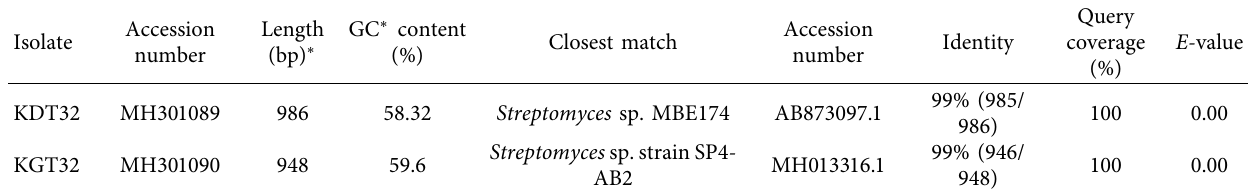
Figure 8: The amplified 16S rRNA gene product of KDT32 and KGT 32 isolates using 2% gel. Ladder: gel pilot mid-range ladder, 100 lanes, six fragments, 100 to 2000bp (QIAGEN) and NC: negative control (master mix). Table 3: The closest match species from GenBank database with sequences of KDT32 and KGT32 isolates.